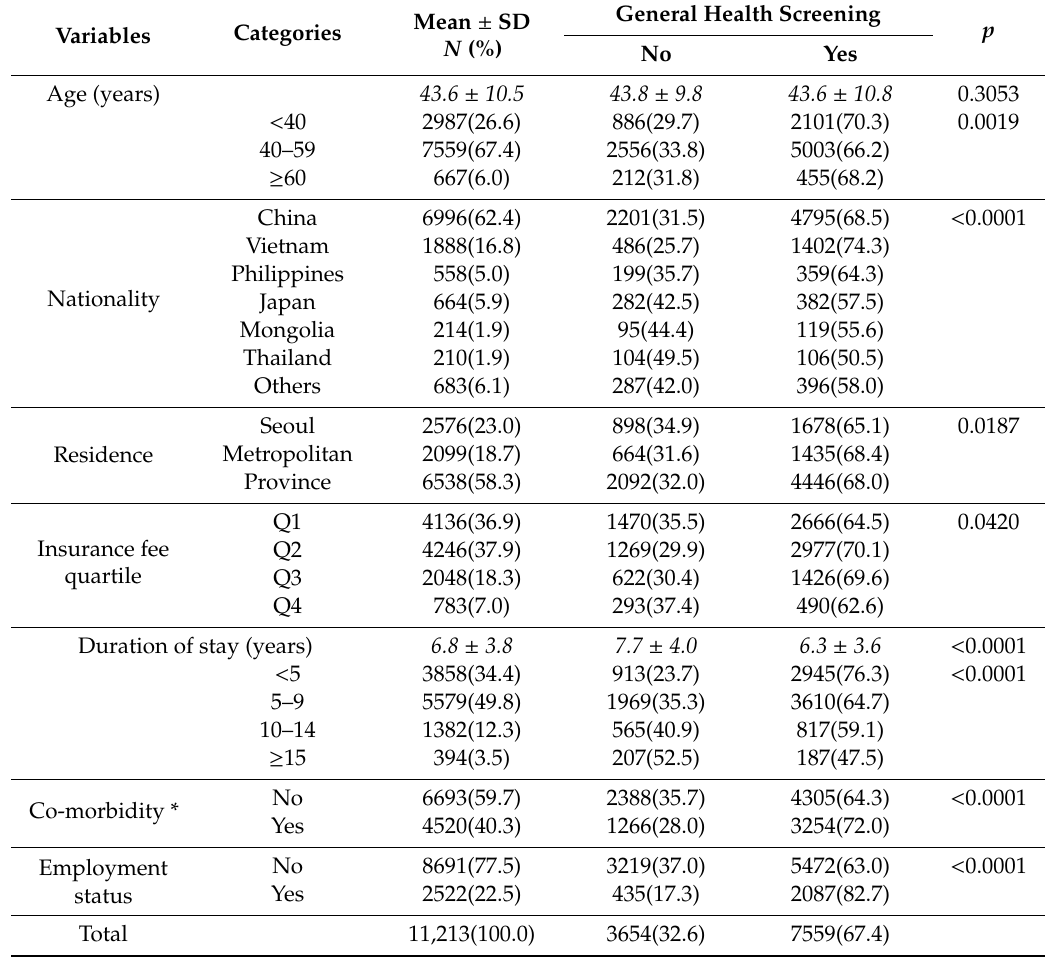
Table 1. General characteristics of eligible